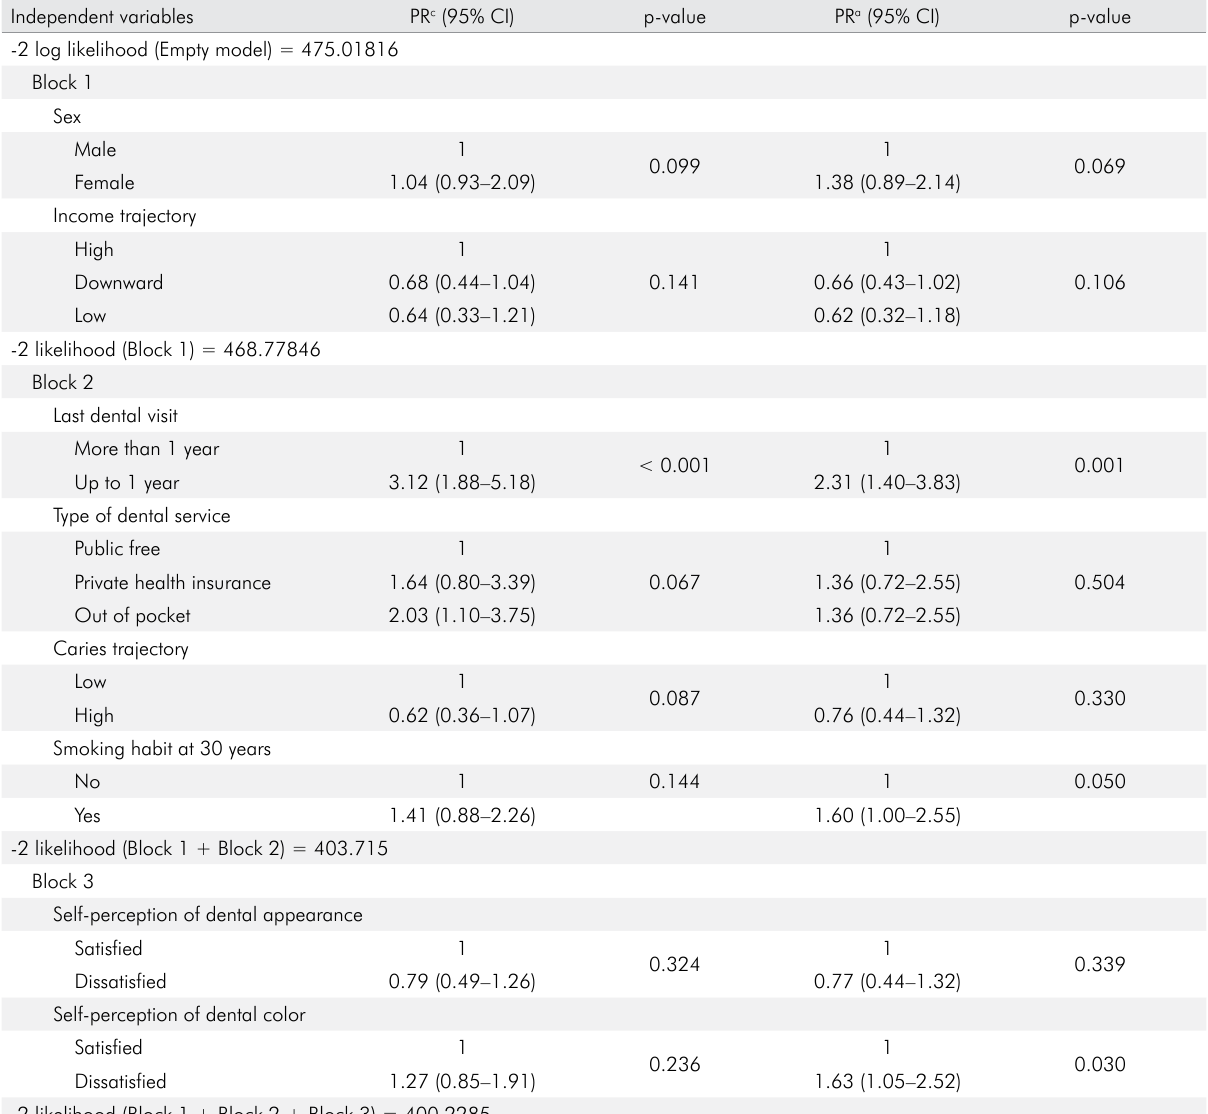
Table 2. Crude (c) and adjusted (a) prevalence ratios (PR) for factors associated with tooth bleaching in individuals from 1982 Pelotas birth cohort (n = 536). Poisson regression